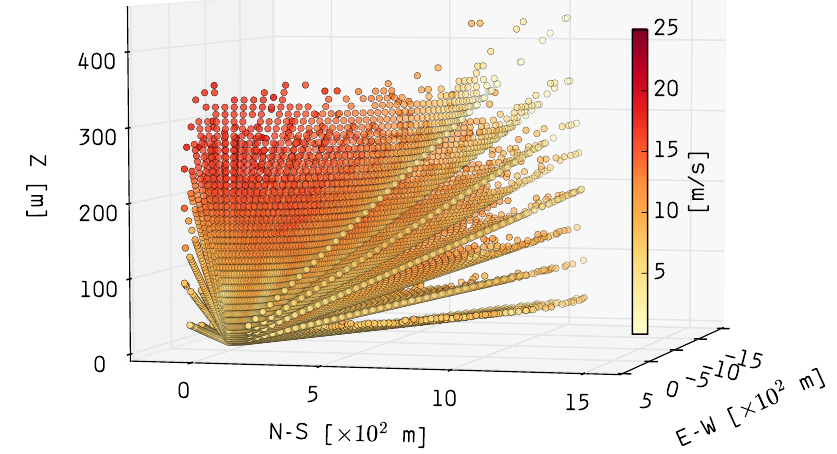
Figure 1. Scanning geometry used during the experiment, with example retrieved radial velocity measurements U r (shading). The instrument location is at the origin, and the coordinates are aligned with the north-south (N-S) and east-west (E-W) directions. Note that the vertical axis is exaggerated for readability.